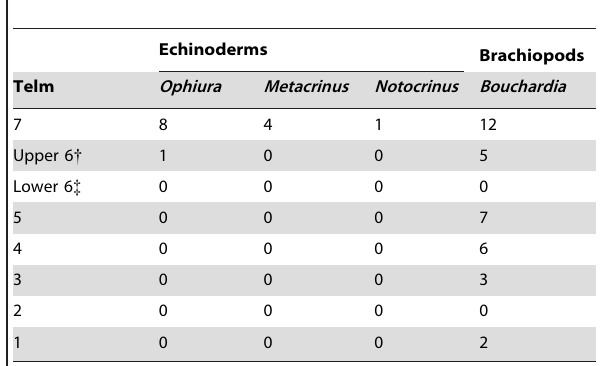
Table 1. Occurrences of fossil assemblages representing dense populations of epifaunal suspension-feeders in the Telm units of the La Meseta